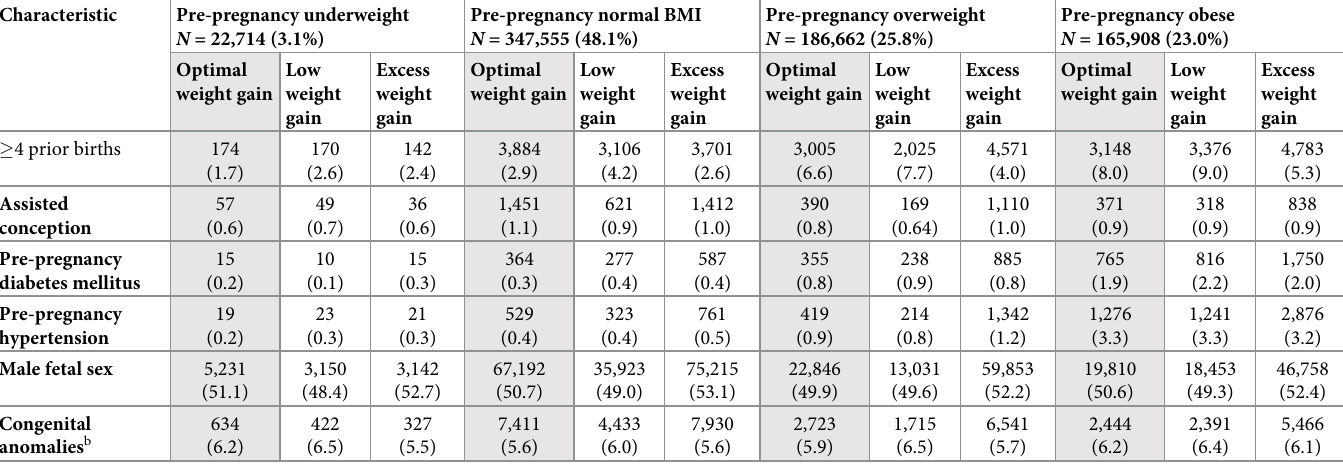
category (Table 1). Except for underweight women, women with excess weight gain were more likely to have private health insurance. Among those with low and normal pre-preg- nancy BMI, women who had excess weight gain were more likely to smoke during pregnancy and less likely to be married than women with optimal weight gain (Table 1). Women with excess weight gain were also more likely to have gestational hypertension, chorioamnionitis, induced labour, premature rupture of membranes, and cesarean delivery (Table 2). Maternal outcomes in women with low gestational weight gain Overall, women with low gestational weight gain had a significantly higher rate of maternal death than women with optimal weight gain (7.97 versus 2.63 per 100,000, p = 0.027). The rates of maternal death/SMM were 1.57%, 1.55%, 1.90%, and 1.75% among underweight, normal weight, overweight, and obese women, respectively (S2 Table). Among normal weight and overweight women, those with low gestational weight gain had higher adjusted odds of maternal death/SMM compared with those who had optimal gestational weight gain (AOR 1.12, 95% CI 1.04–1.21, p = 0.004, and AOR 1.17; 95% CI 1.04–1.32, p = 0.009, respectively; Table 3). Women who had normal pre-pregnancy BMI and low weight gain had elevated odds of cerebrovascular/central nervous system morbidity, while overweight women had increased odds of ICU admission (S4 Table). Maternal outcomes in women with excess gestational weight gain The maternal death rate among women with excess weight gain was 3.98 per 100,000 (versus 2.63 per 100,000 in the optimal weight gain group, p = 0.394). The rates of maternal death/ SMM were 1.94%, 1.54%, 1.56%, and 1.81% among underweight, normal weight, overweight, and obese women, respectively (S2 Table). Adjusted for other covariates, among underweight, normal weight, and obese women, excess gestational weight gain was associated with